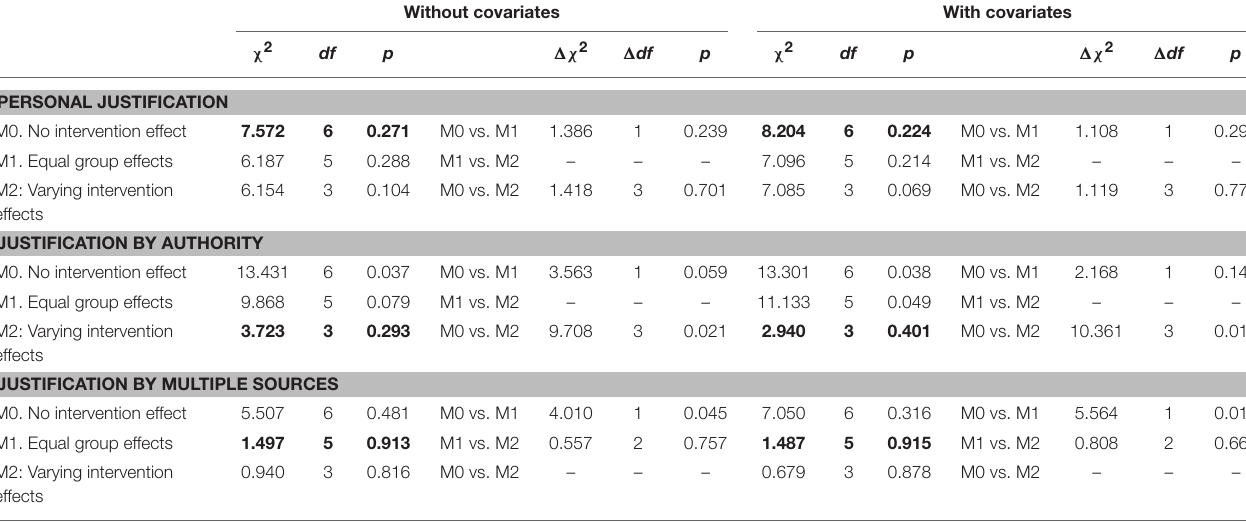
TABLE 8 | Fit indices and model difference tests for psychology-specific justification beliefs. Without covariates